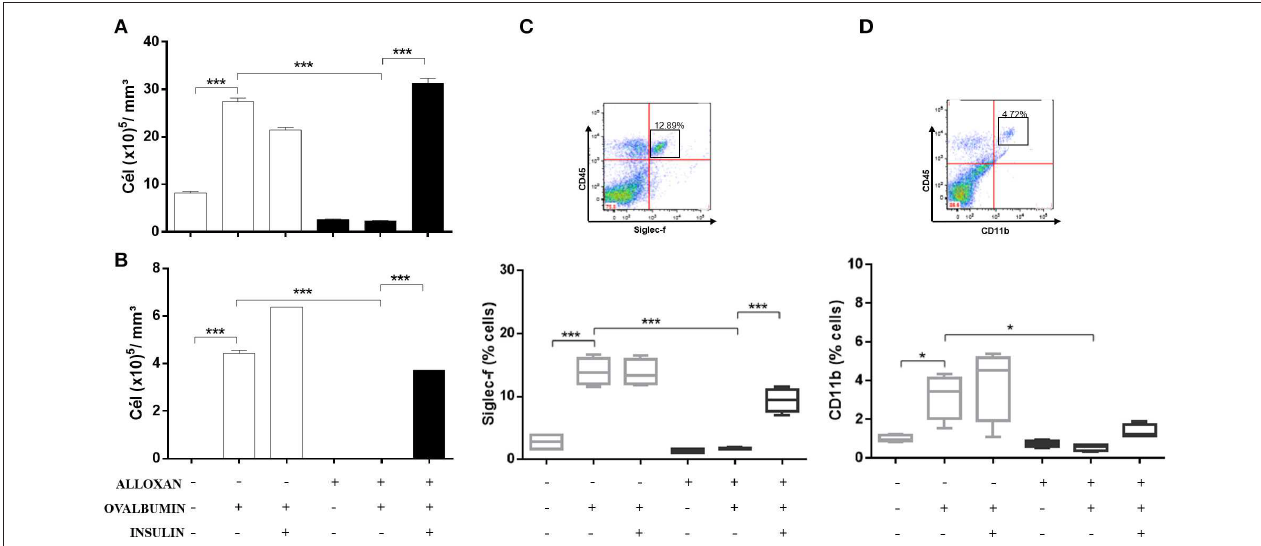
FIGURE 3 | Characterization of leukocytes in BALF: the role of insulin. Animals were sensitized with OVA + Al(OH) 3 (i.p.) 10 days after alloxan administration and 12 days after sensitization. Six days after the booster dose, the animals received 7 antigenic challenges daily with OVA or saline. NPH insulin treatment was performed between the 2 IU challenges of NPH insulin at 7 p.m. and 1 IU of NPH insulin at 7h. Twenty-four hours after the last challenge, the animals were euthanized, and BALF was collected. (A) Total cells. (B) Eosinophils. (C) Siglec-f. (D) CD11b. Values represent the mean ± SEM from three independent experiments. * p < 0.05; *** p < 0.001. The groups were tested with two-way analysis of variance followed by Tukey–Kramer post-hoc tests (GraphPad Prism version 6.0 for Windows, GraphPad Software, La Jolla, CA,